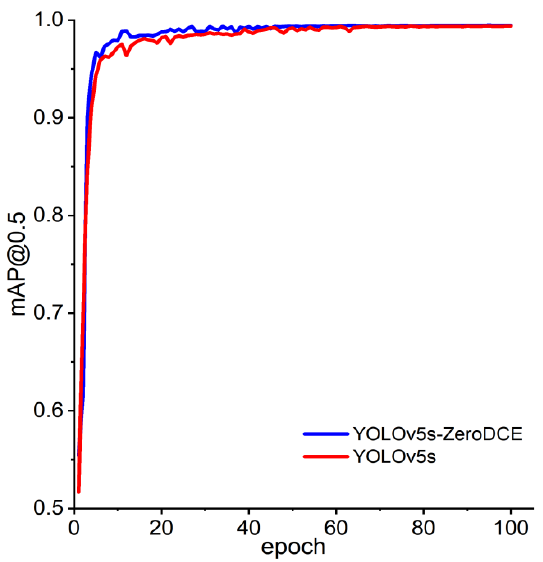
Figure 16. Comparison chart of mAP between yolov5s-ZeroDCE and YOLOv5s.